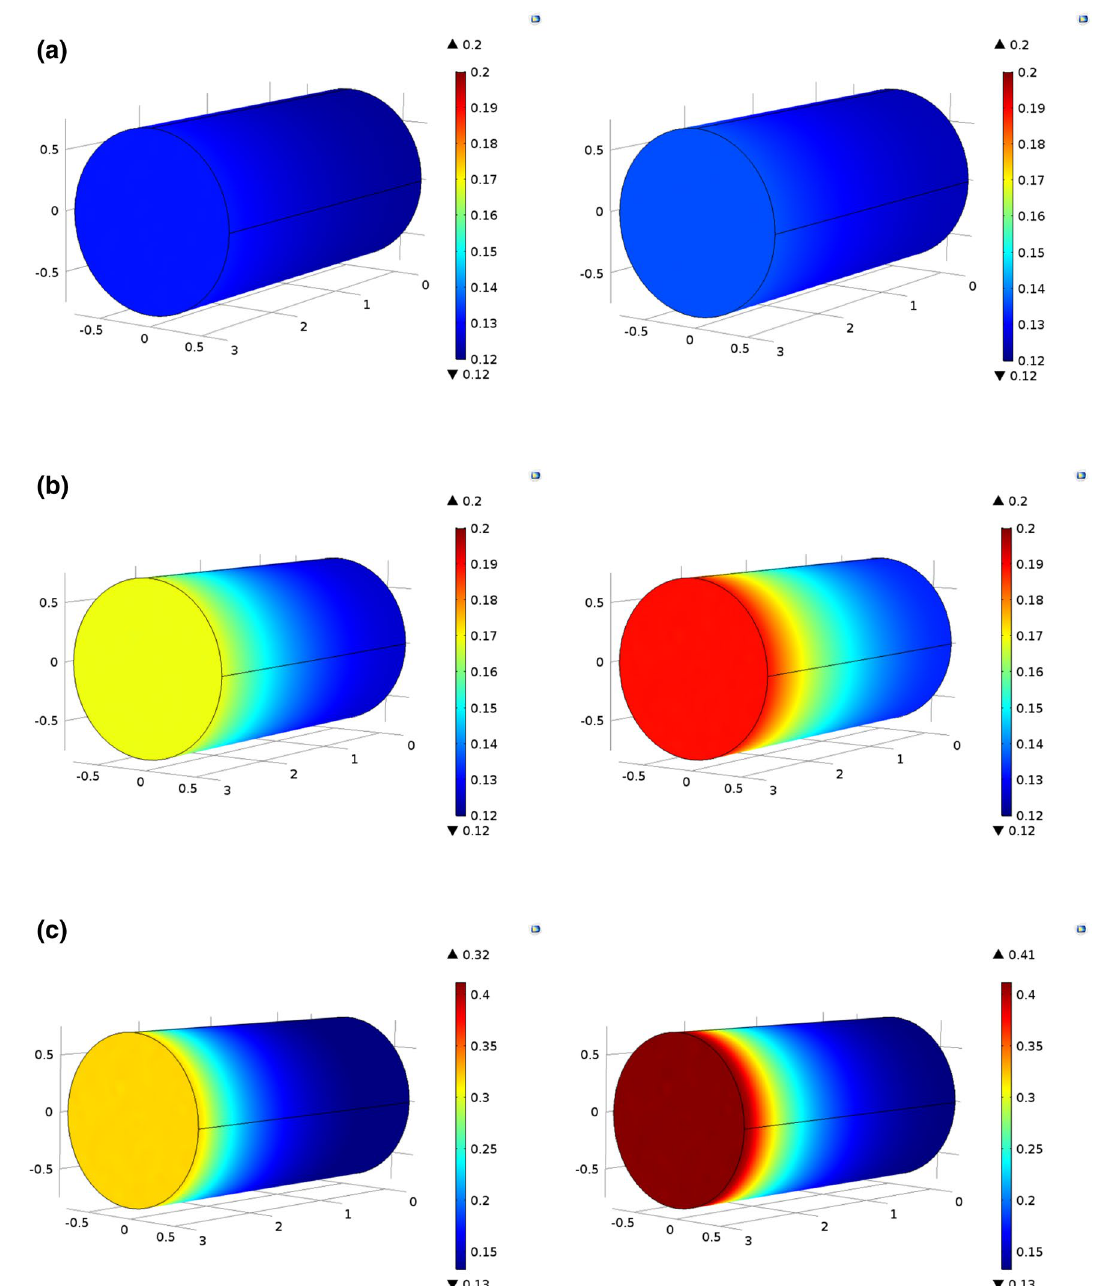
Fig. 4 Porosity distribution after 25 min (left) and after 35 min (right) of fluoroboric acid injection at a 25 °C, b 65 °C and c 105